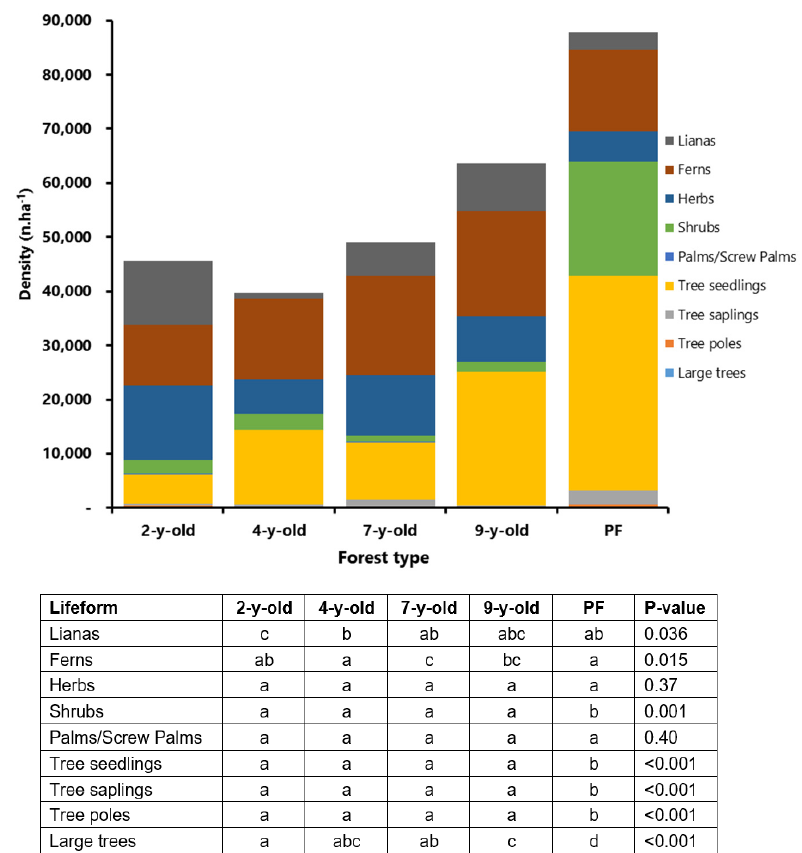
Figure 5. The mean density of vegetation lifeforms in fallow forests between two- and nine-years-old and primary forest (PF) in coastal areas of north Manokwari, West Papua, Indonesia. Plant density in smaller plots is multiplied accordingly to give the equivalent area sampled for each lifeform. For clarity, error bars are omitted. Different lowercase letters in the table show the differences according to ANOVAs and Tukey’s tests with p <